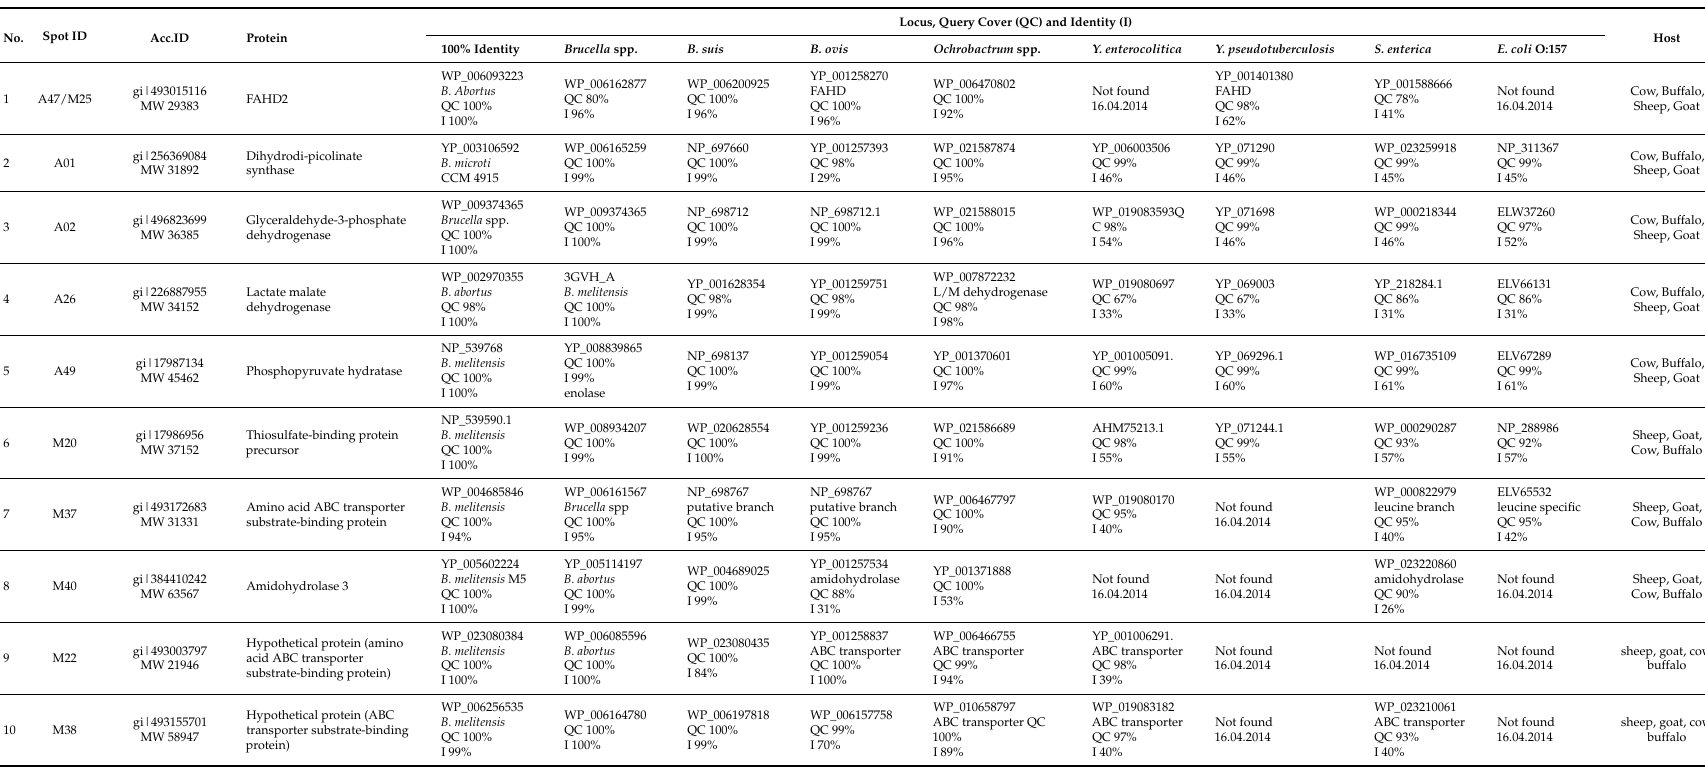
Table 4. Comparative Blast search between the identified proteins obtained from B. abortus and B. melitensis field strains and from proteins of putatively cross-reacting bacteria (A: B. abortus ; M: B. melitensis ); low cross-reactivity % values are in bold text. Acc.ID: Accession number at NCBI; Y: Yersinia ; S: